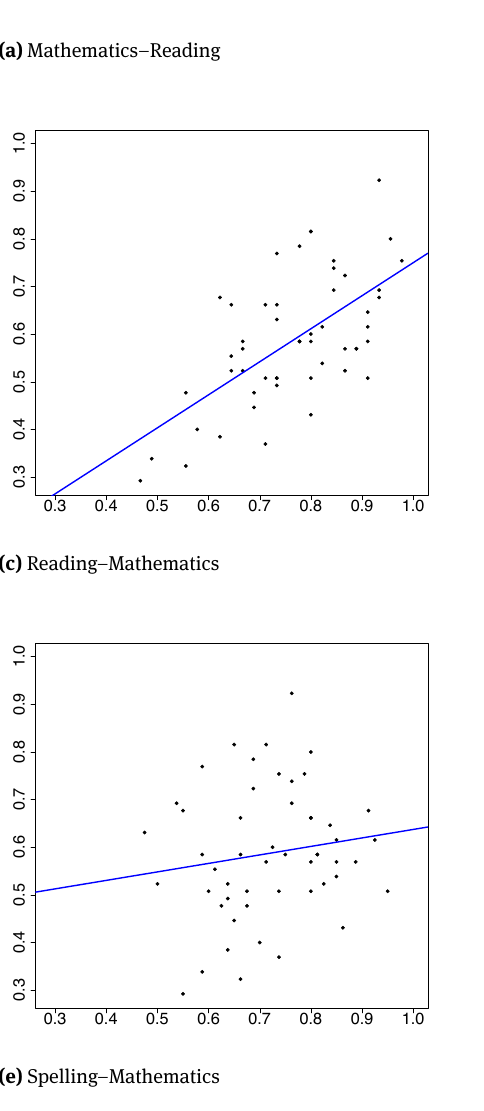
Figure 2: Scatterplots and least-squares regression